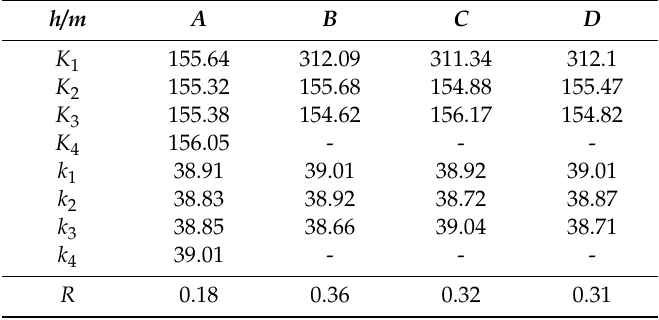
Table 8. 0.6 Q head analysis.